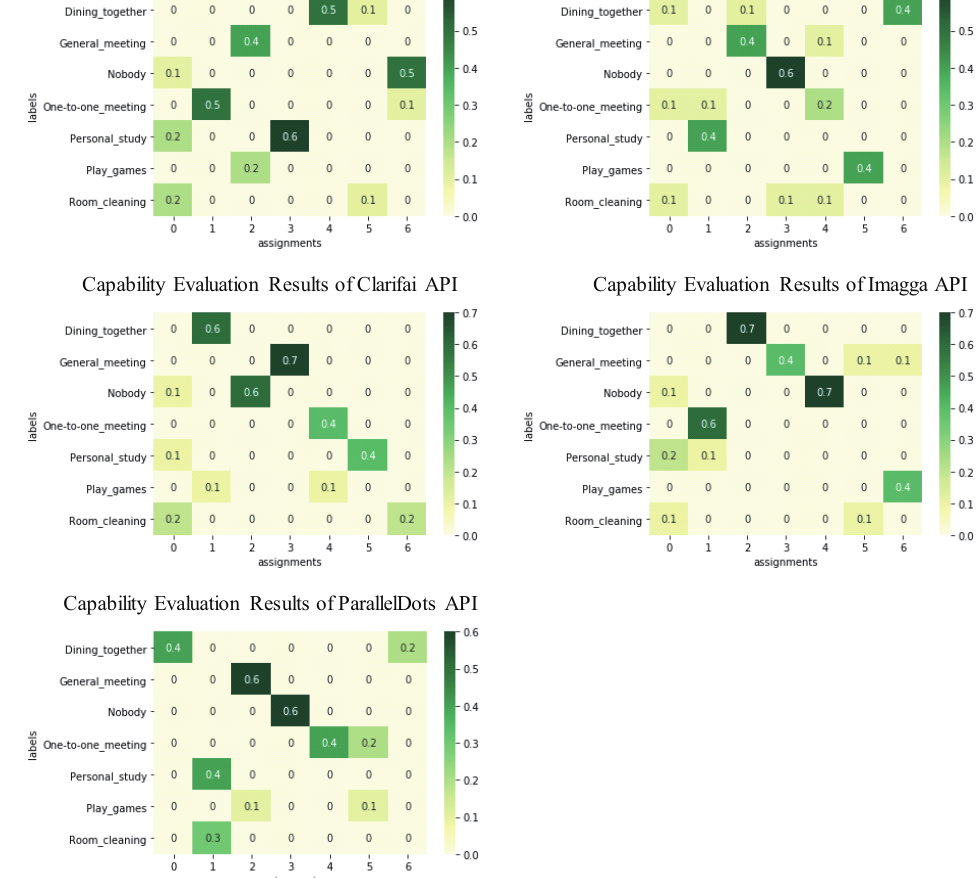
Figure 4. The capability evaluation results of five cognitive APIs in this